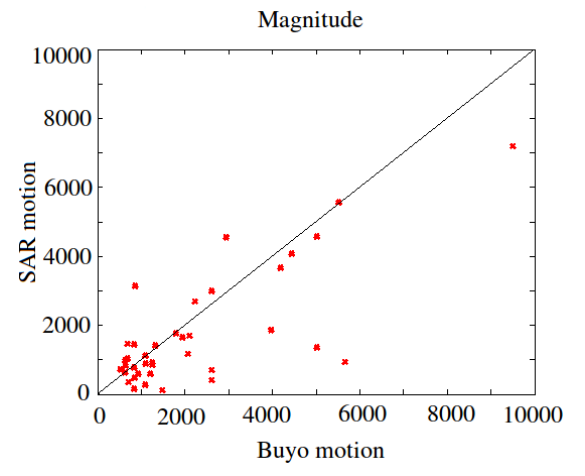
Fig. 8. Magnitude of the buoy motion and estimated motion for the long drift data in meters. One outlier with a buoy motion larger than the maximum algorithm detecting capability is located outside of the illustrated